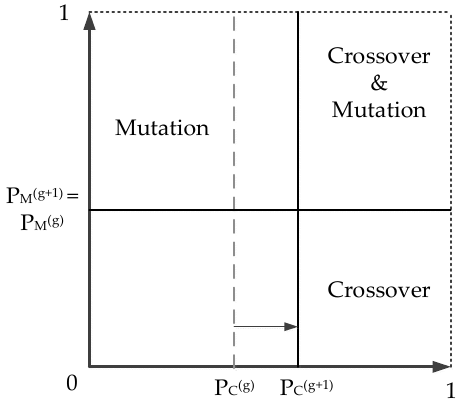
Figure 6. Variation for decreasing crossover probability.